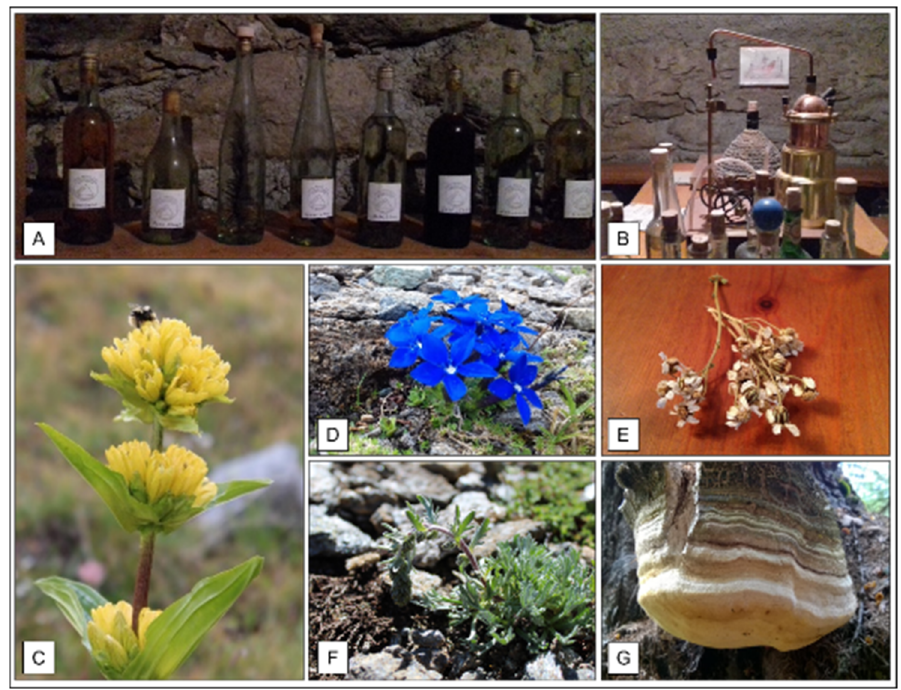
Figure 3. Liquoristic use: ( A , B ) Artisan distillery and several bottles of typical liqueurs and grappas; ( C ) Gentiana punctata ; ( D ) Gentiana verna ; ( E ) Achillea erba-rotta ; ( F ) Artemisia genipi ; ( G ) Phomitopsis officinalis .